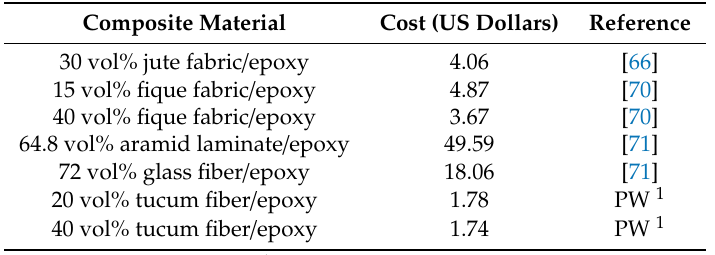
Table 4. Cost comparison of composites with natural and synthetic